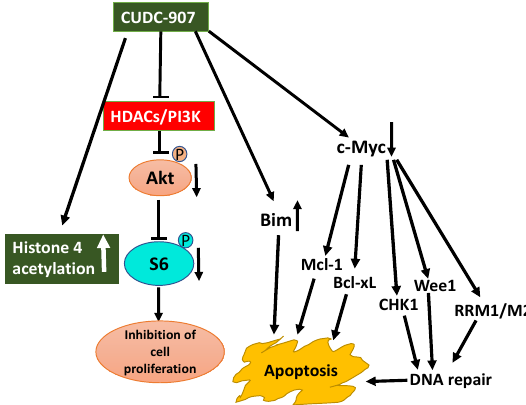
Figure 5. Schematic display of antitumor activity of CUDC-907 hybrid drug against prostate cancer cells. Synergistic anti-cancer activity of CUDC-907 is illustrated by its inhibition of HDACs activity and PI3K / Akt pathway [144]. Increase in histone 4 acetylation and reduced activation of PI3K / Akt confirms its dual action on HDAC and PI3K. Outcome of these e ff ects resulted in inhibition of cell proliferation, increase in DNA damage due to downregulation of DNA damage repair response proteins, and apoptosis because of downregulation of c-myc and antiapoptotic Mcl-1 and Bcl-xL proteins, and upregulation of pro-apoptosis protein Bim (blunt end lines indicate inhibition, upward arrows indicate upregulation and downward arrows indicate downregulation of proteins).